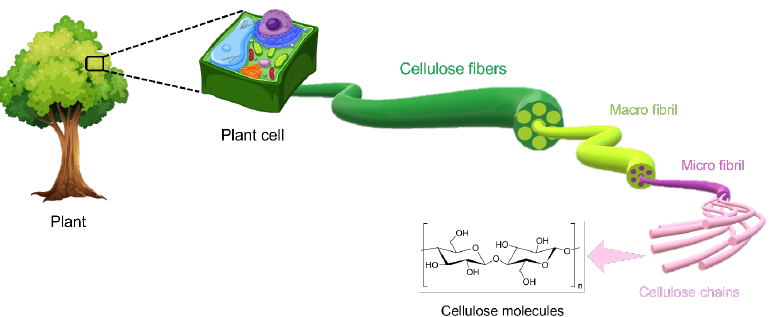
Figure 2. The hierarchical structure of cellulose. Reproduced under terms of the CC-BY license [6]. Copyright © 2020, The Authors, published by Front. Chem.